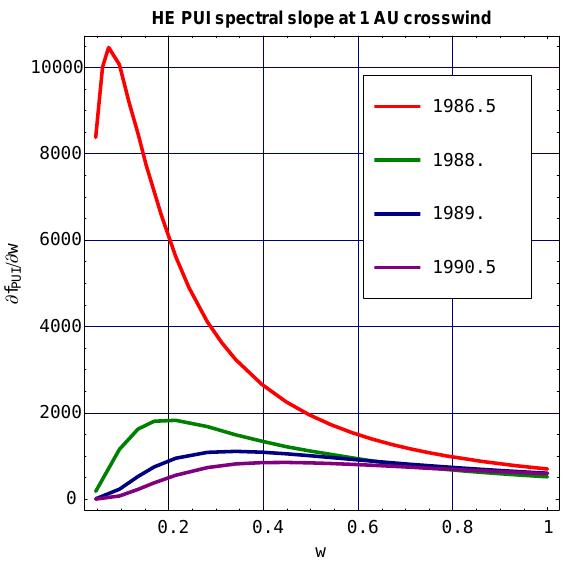
Fig. 19. As Figs. 17 and 18 but for an intermediate phase of the solar cycle ( t = 1988 . 0).